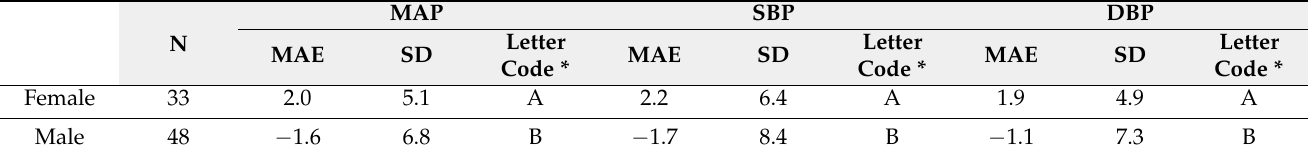
Table 8. Efficacy by